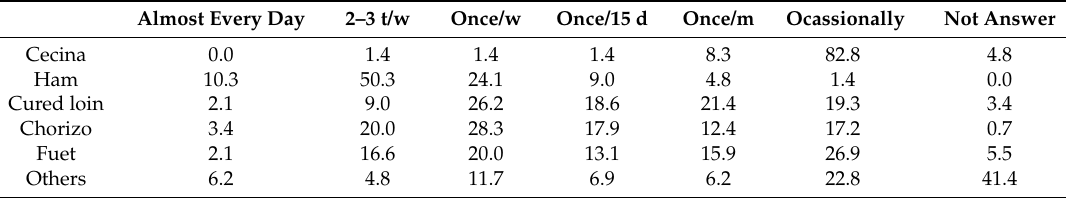
Table 1. Frequency of consumption of different meat products (percentage; n = 145 consumers). Almost Every Day 2–3 t/w Once/w Once/15 d Once/m Ocassionally Not Answer Cecina 0.0 1.4 1.4